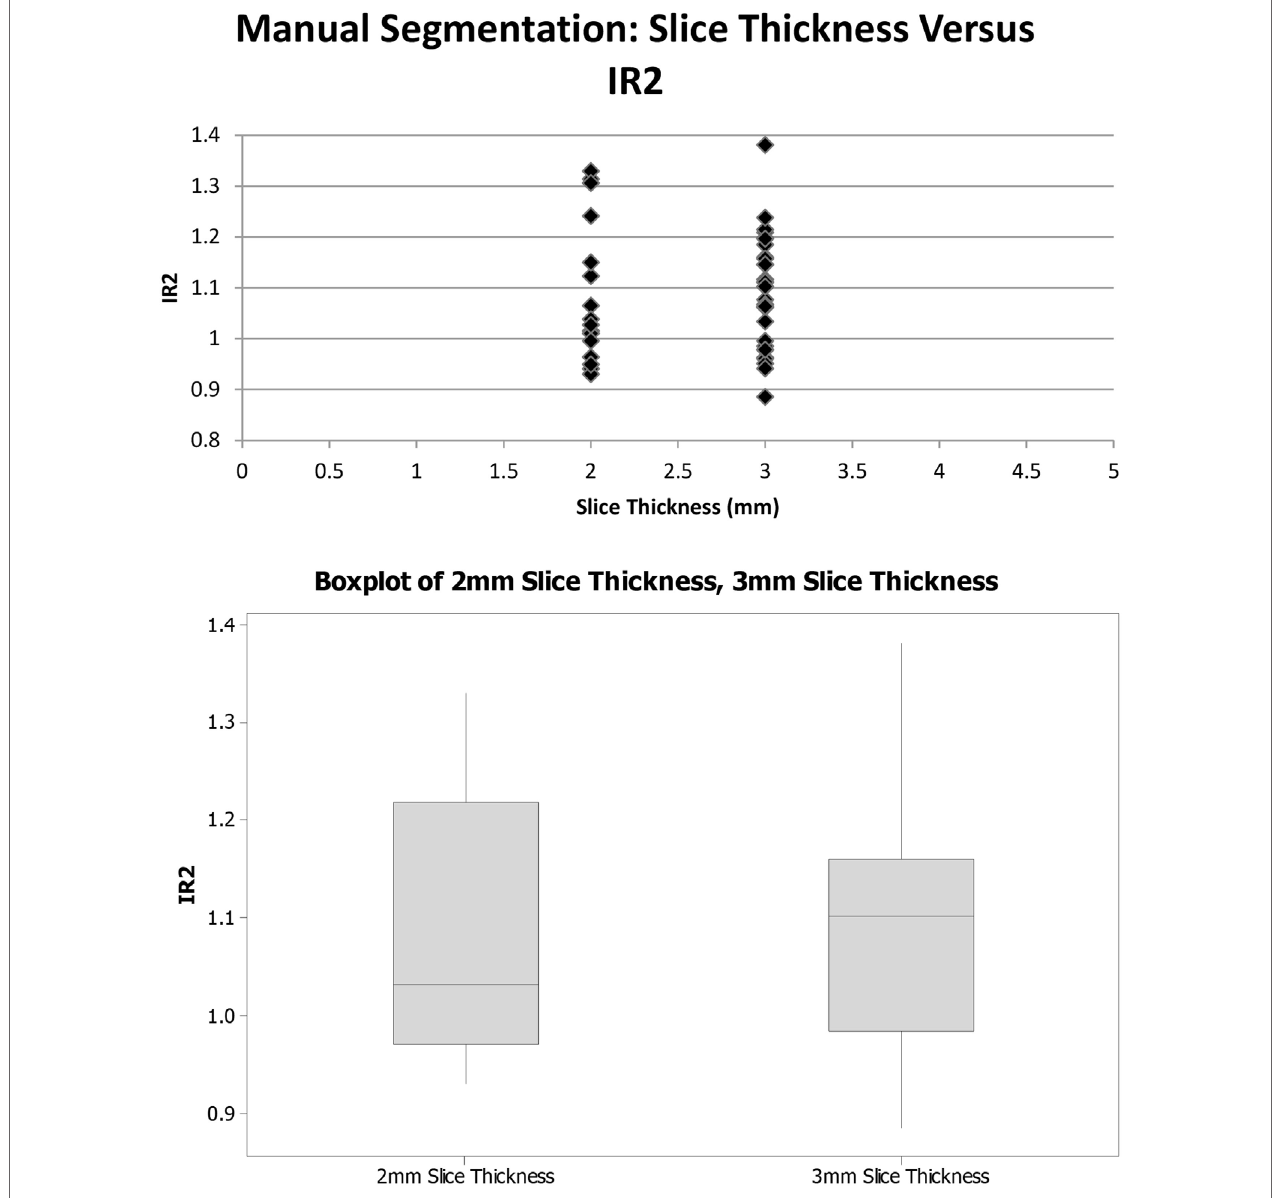
FigUre 5 | slice thickness and voxel intensity ratios (ir2)